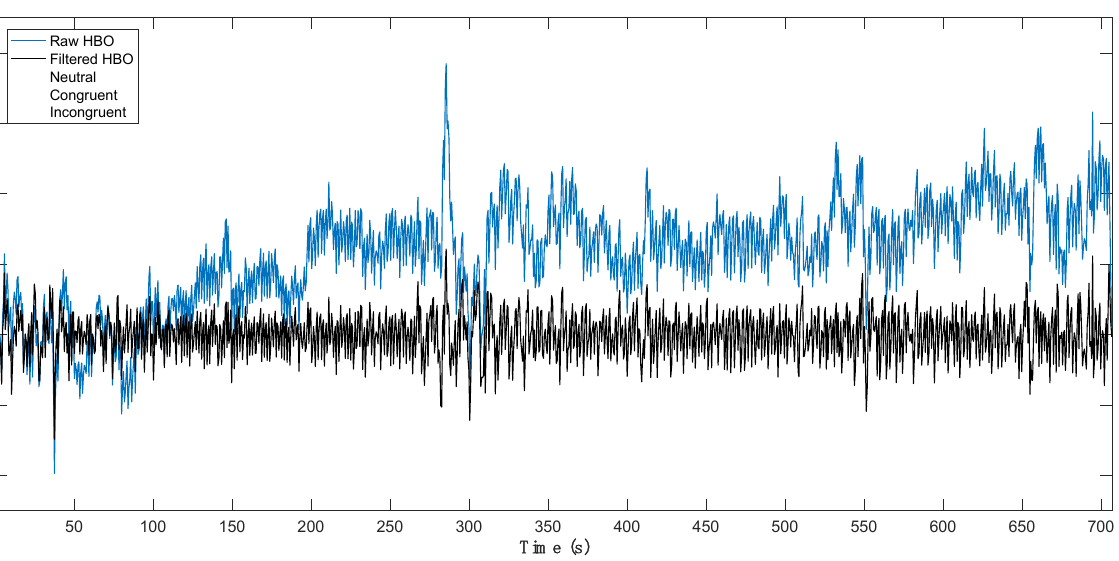
Figure 1. Types of stimuli that were presented within the color–word Stroop experiment. Samples of trial presentations are schematically represented for match (top row) and non-match conditions (bottom row) of ( A ) neutral, ( B ) congruent, and ( C ) incongruent stimuli.